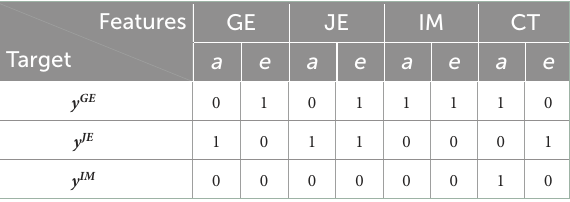
TABLE 2 Lasso feature selection result ( a -additive term of fitting function = the maximum performance, e - exponential term of fitting function = the learning rate).